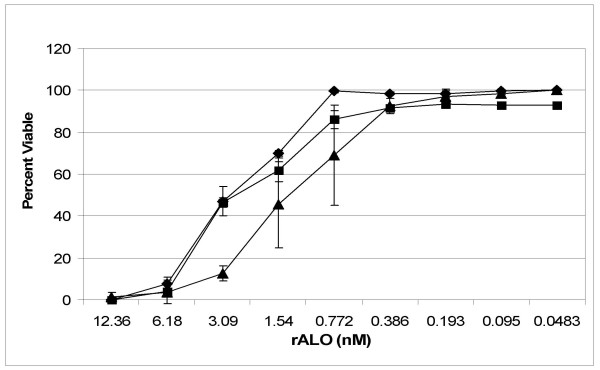
Recombinant ALO lyses human monocyte derived macrophages (hMDMs) in a dose dependent manner. Percent viability of primary human monocyte derived macrophages after 30 min incubation at 37°C with varying concentrations of rALO in serum free conditions. The means and standard deviations of three independent experiments performed in duplicate are shown. Each experiment was performed with hMDMs from different donors (represented by ▲, ◆, ■) (▲, Spearman correlation is -0.917, p = 0.001. ◆, Spearman correlation is -0.962, p < 0.001. ■, Spearman correlation is -0.852, p = 0.015).